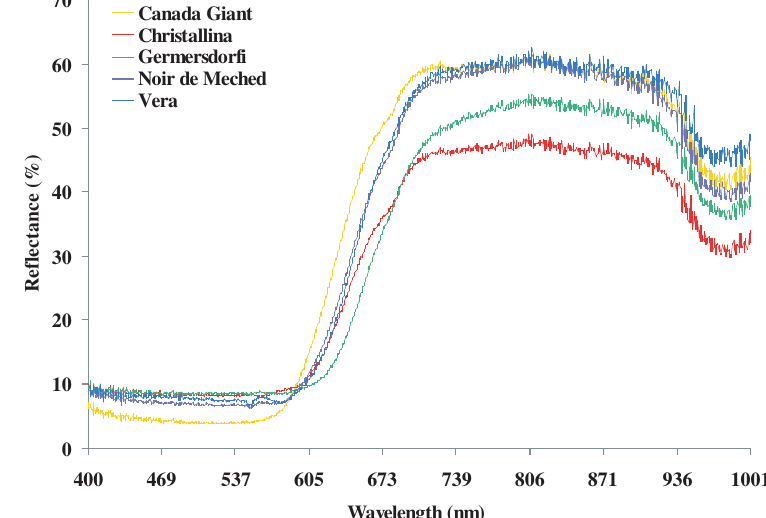
0102030405060704004695376056737398068719361001Wavelength(nm) R e f l ec t a n ce ( % ) CanadaGiantChristallinaGermersdorfiNoirdeMechedVera Figure 2. Spectral properties of different cherry fruits